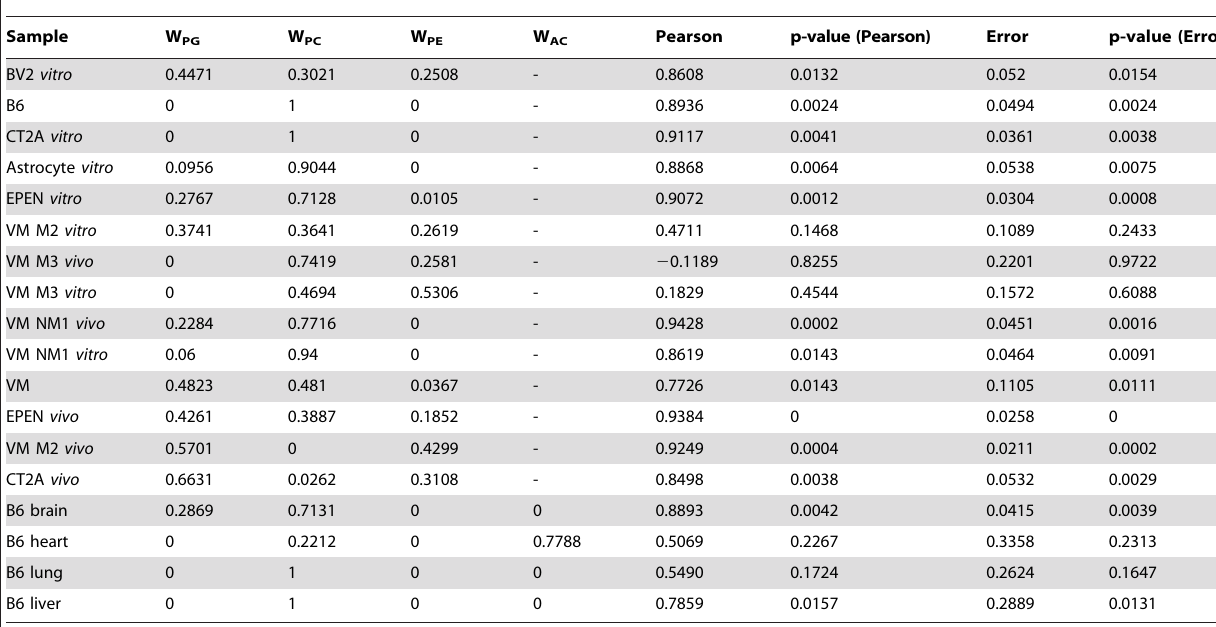
Table 2. Proportional incorporation model: inferred remodeling parameters and performance.